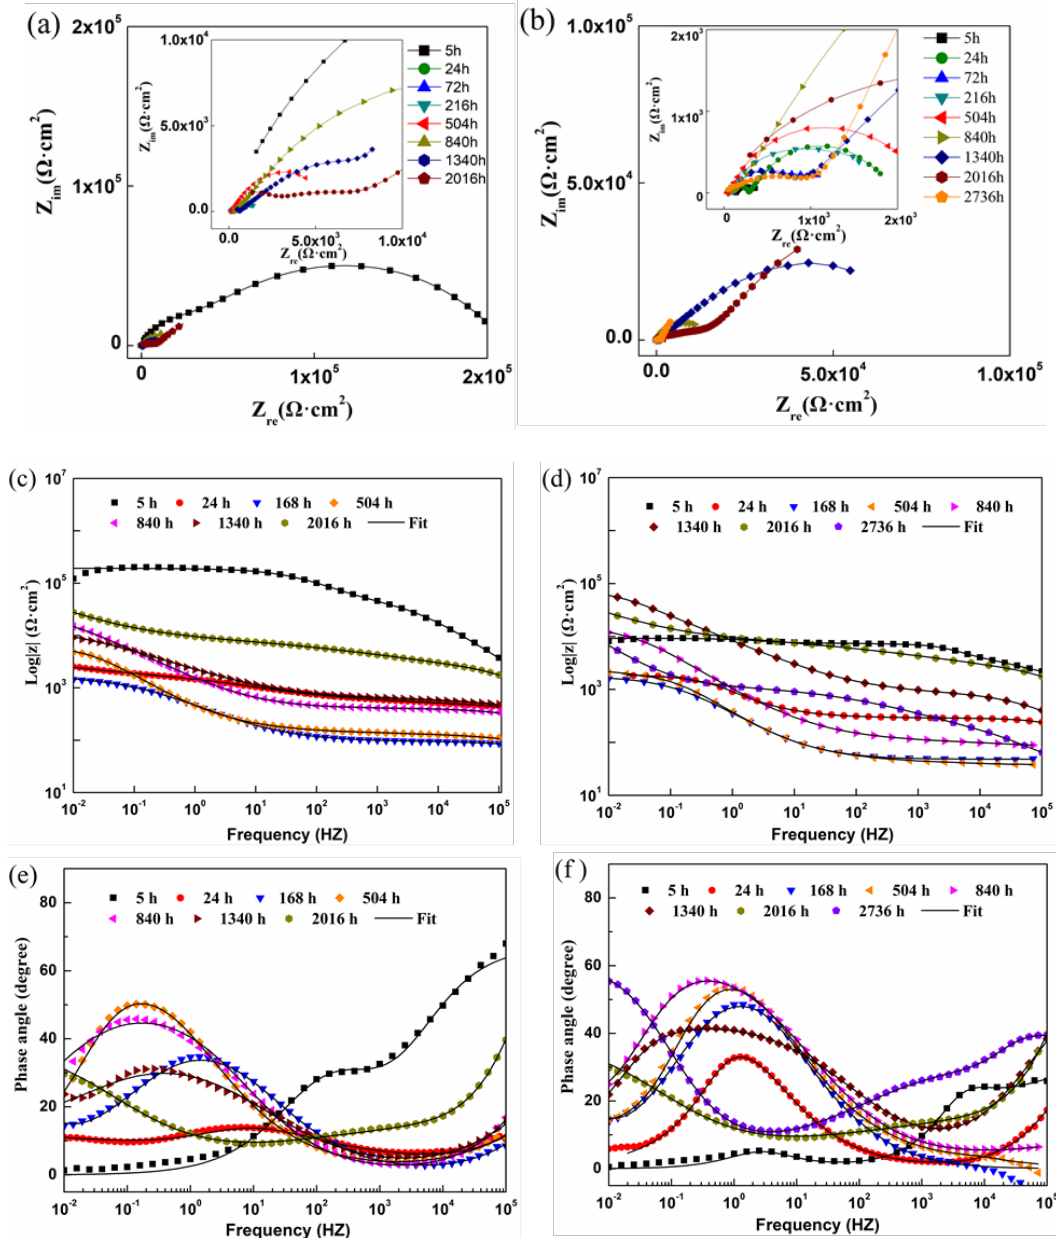
Figure 8. Electrochemical impedance spectroscopy (EIS) spectra of coatings after immersion in 3.5 wt % NaCl solution for different times. ( a , c , e ): CGC and ( b , d , f ): CPTES/CGC.